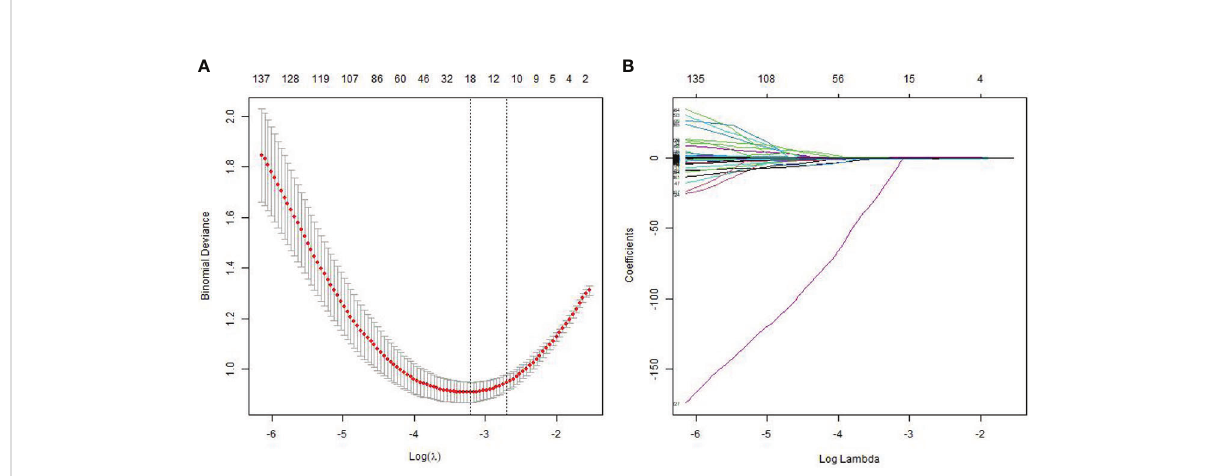
FIGURE 2 Feature selection using the least absolute shrinkage and selection operator (LASSO) regression model. The cross-validation plot (A) and the coef fi cient pro fi le plot (B) .